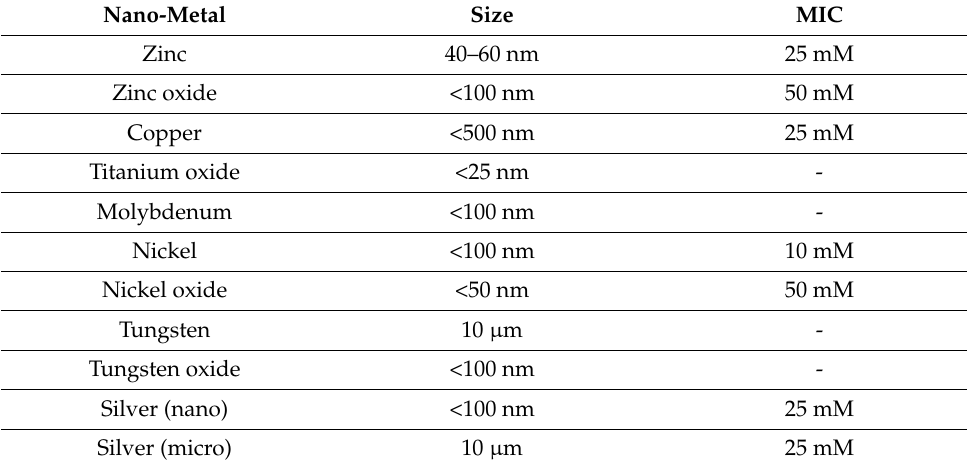
Table 1. The list of tested metal particles. This table presents the tested metal particles with the indi- cated sizes given by the manufacturers; the minimum inhibitory concentration assay was performed on P. aeruginosa in our laboratory and the results are presented as MIC in the table. All nanoparticles were purchased from Sigma, with the exception of silver microparticles, which were from Biogate (Bremen, Germany).